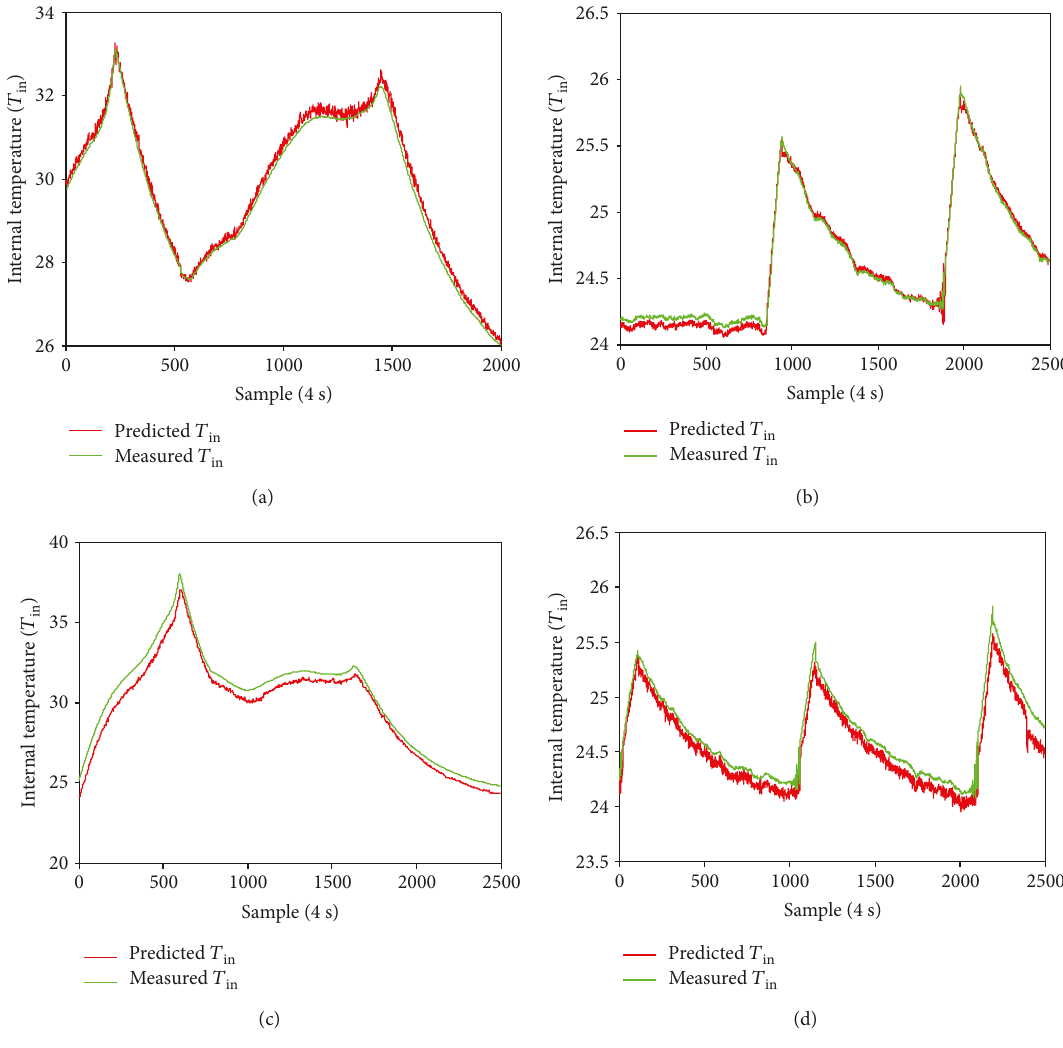
Figure 7: Validation results for T